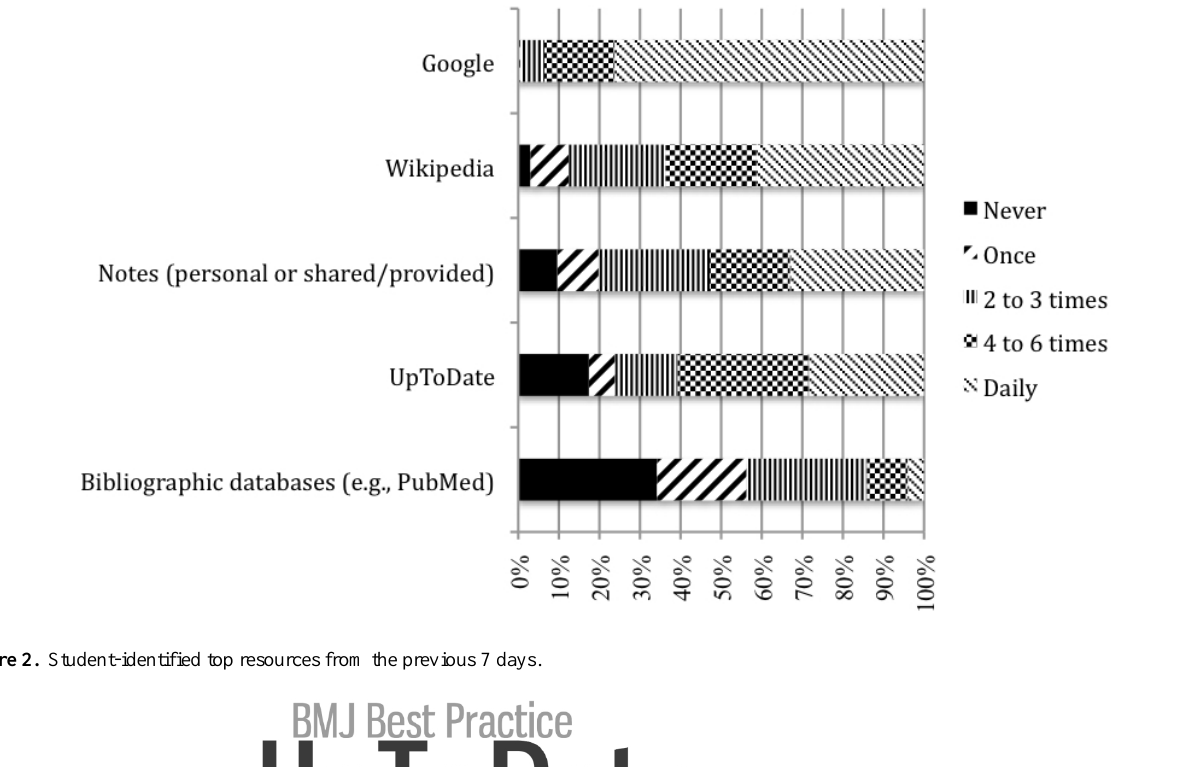
Figure 1. Student self-reported use of resources in the previous 7 days.